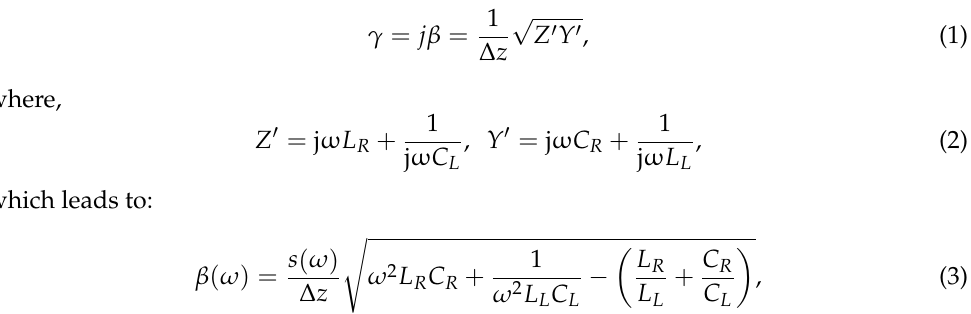
where β ( ω ) is the phase constant of a TL, s ( ω ) and ∆ z are the sign function and the length length of unit cell, respectively. For the balanced case, i.e., (cid:1838) (cid:3019) (cid:1829) (cid:3013) (cid:3404) (cid:1838) (cid:3013) (cid:1829) (cid:3019) , Equation (3) can of unit cell, respectively. For the balanced case, i.e., L R C L = L L C R , Equation (3) can be